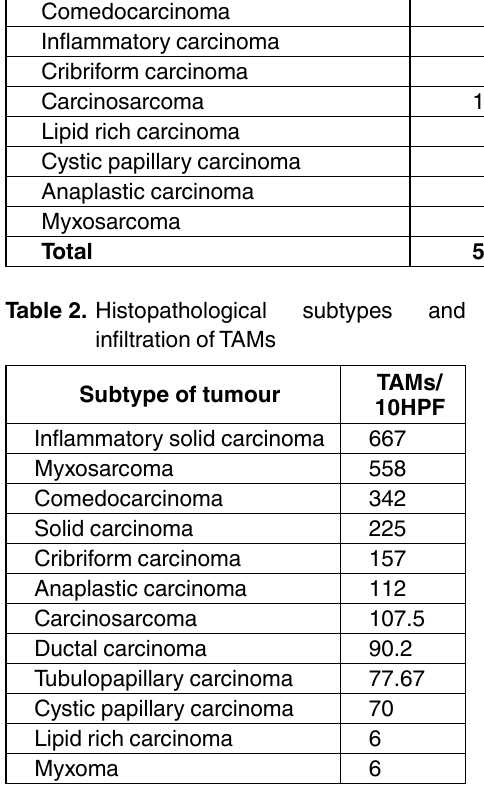
table 3. Malignancy grading and infiltration of TAMs